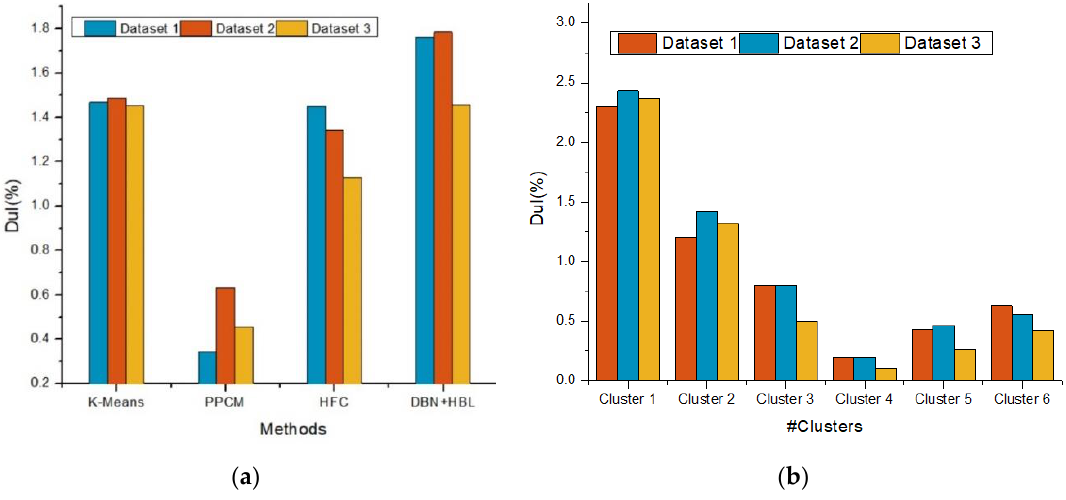
Figure 4. DuI analysis: ( a ) methods, ( b ) clusters.